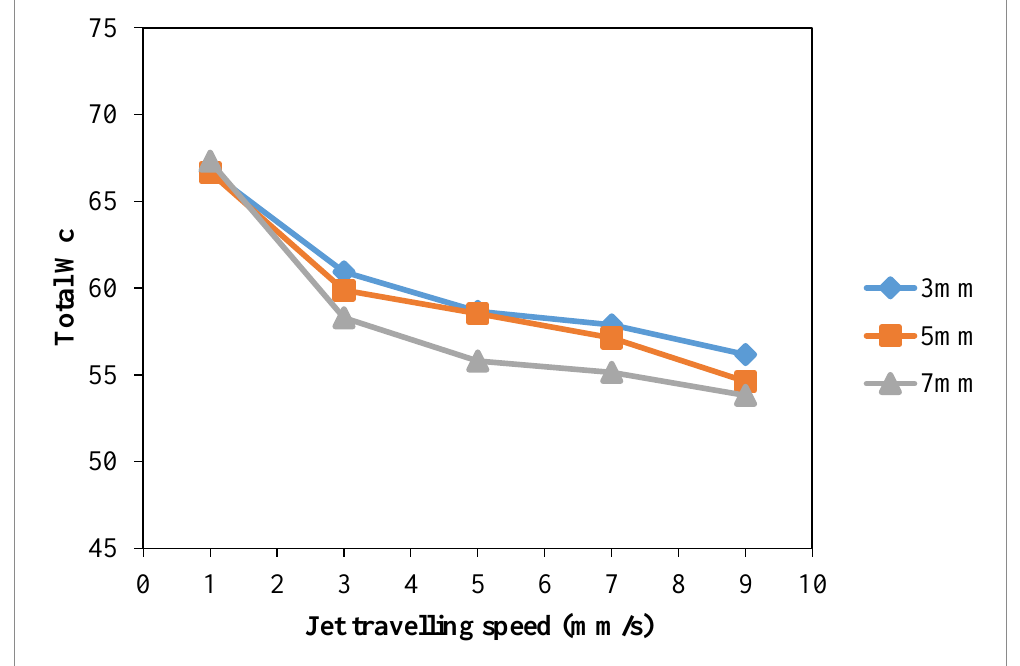
Figure 12. Effect of jet travelling speed on total W c (adapted from Ref. [29], with permission) (Jet travelling speed: 1 mm/s, 3 mm/s, 5 mm/s, 7 mm/s and 9 mm/s; Jet-to-substrate distances: 3 mm, 5 mm and 7 mm; Discharge power: 150 W and Oxygen flow rate: 0.4 L/min).